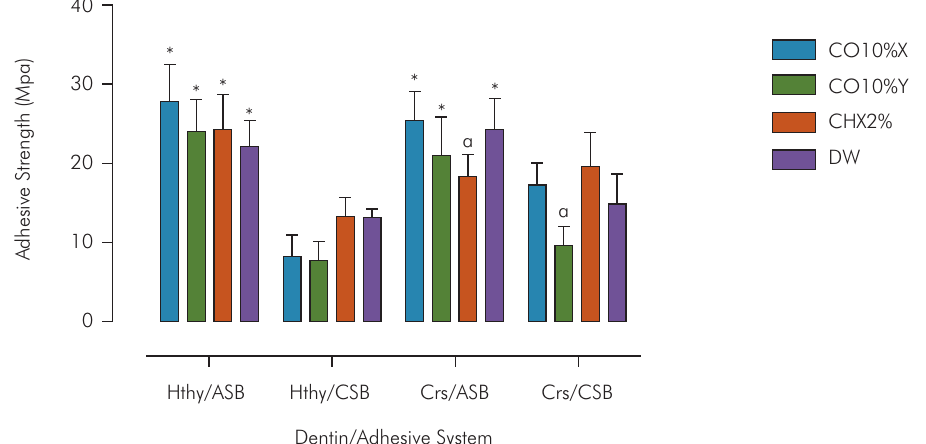
Figure. Adhesive strength according to healthy or carious substrate, test substance for dentin cleaning, and adhesive